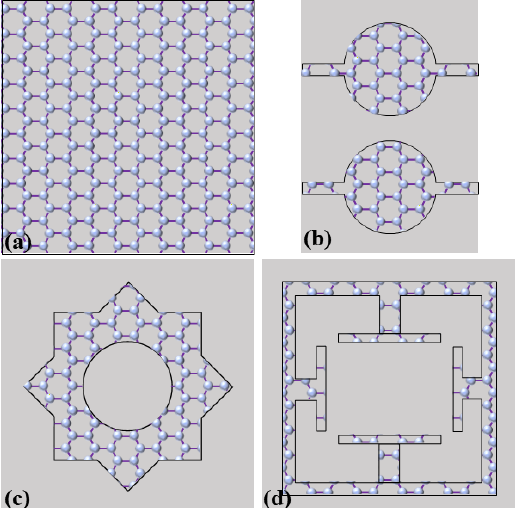
Figure 2. Graphene-based single-frequency/band terahertz metamaterial absorbers. ( a ) Metal wire and continuous graphene film; ( b ) two identical-sized graphene disc elements [31]; ( c ) square-square-circle graphene microstructure [32]; ( d ) four T-shaped graphene strips and a graphene square ring. Adapted with permission from Ref. [33], 2019, Copyright The author.